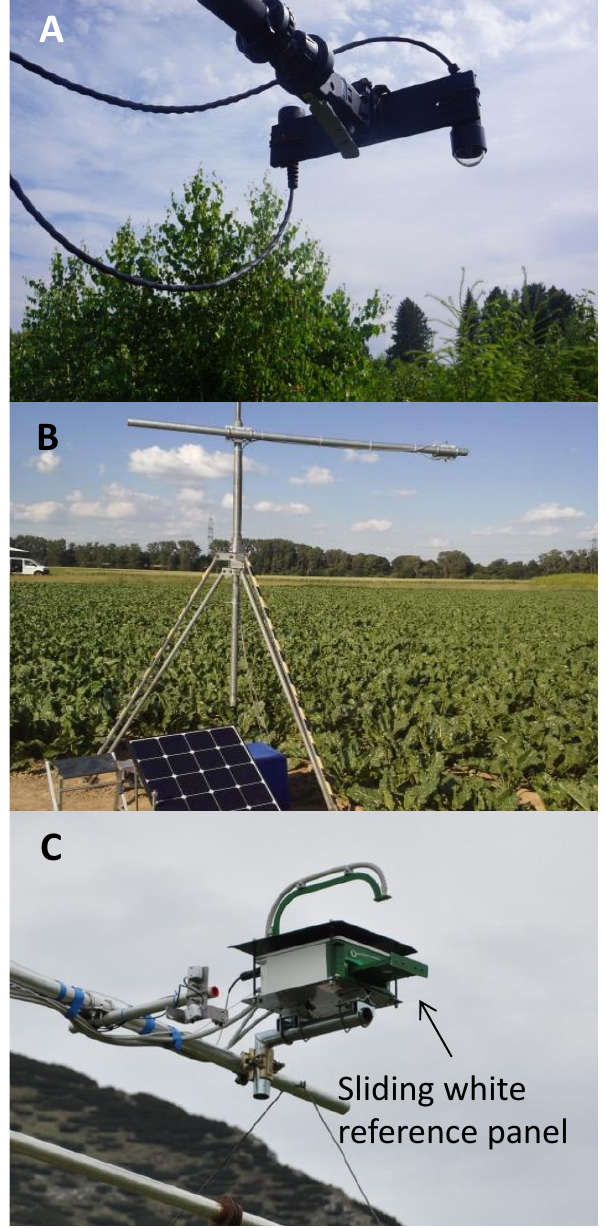
Figure 5. Hyperspectral systems developed during EUROSPEC. The Piccolo system (a) and the SIF-Sys (b) use a single spectrome- ter to measure two fields of view by means of a bifurcated fibre op- tics. The White-Ref system (c) uses a sliding white reference panel to measure irradiance. See further details in the text.